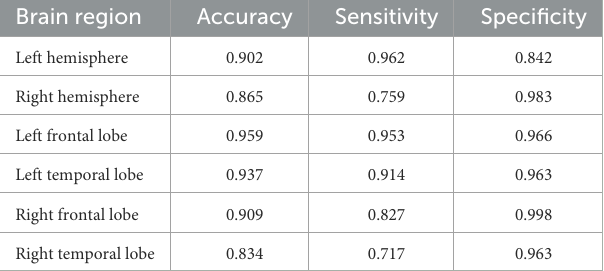
TABLE 3 Comparison of classification effect in different brain regions. Brain region